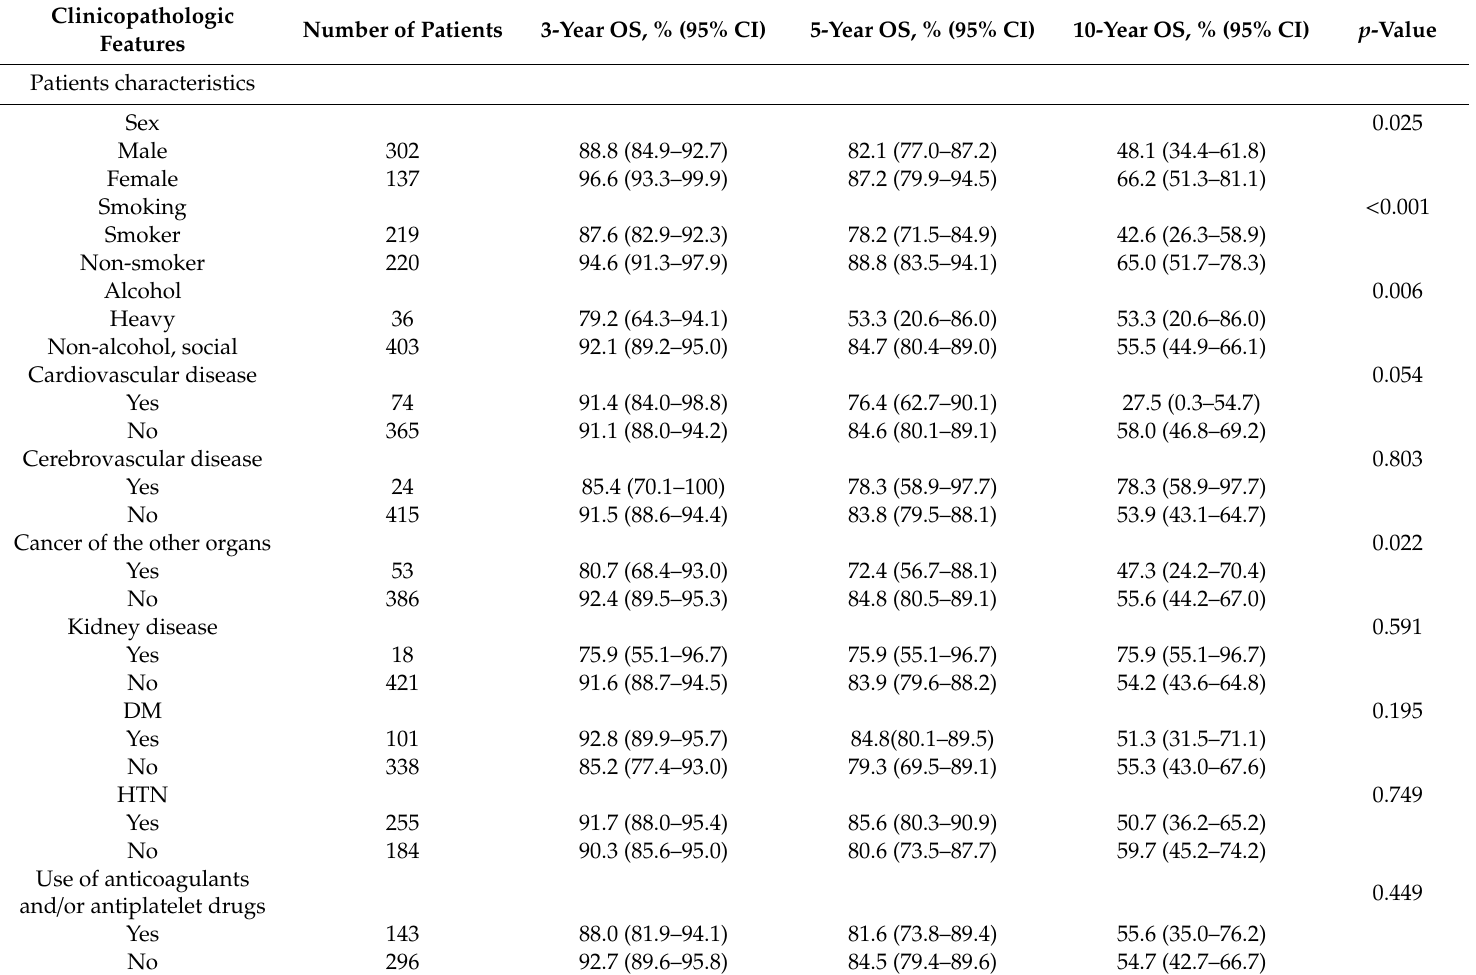
Table 4. Relationship between overall survival and clinicopathologic